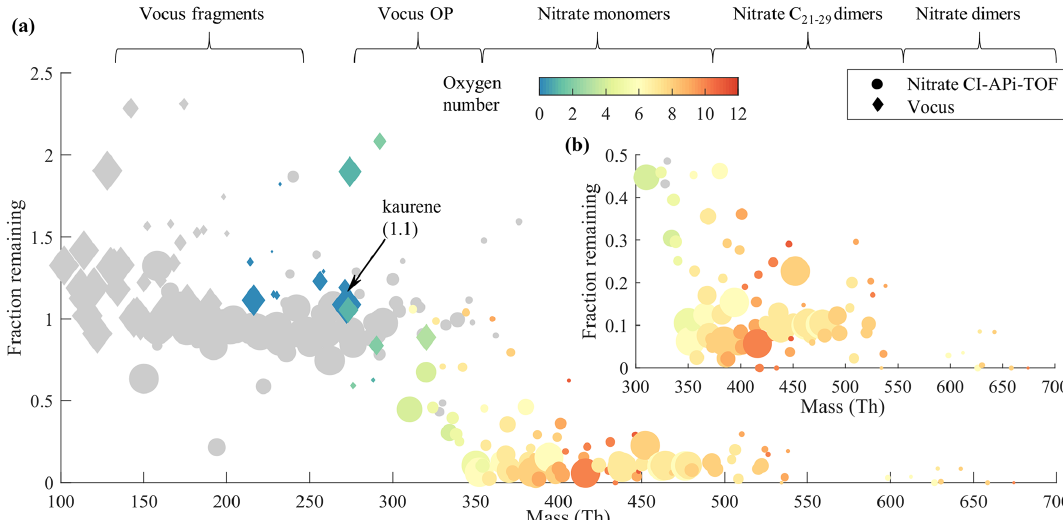
Figure 6. Seed injection behavior; the “fraction remaining” corresponds to the ratio of the signal with seed particles to the signal without seed. We emphasize that the molar mass indicated on the x axis is without the reagent ions, unlike many previous studies (Peräkylä et al., 2020; Räty et al., 2021). Species with less than 15 carbon numbers in the composition are colored with gray, while the color scale indicates the oxygen content for species with 15 or more carbon atoms. The areas of the circles (nitrate CI-APi-TOF) and diamonds (Vocus) are scaled linearly to the magnitude of each compound’s signal when there were no seed particles in the chamber (different scaling for the two instruments). Compounds with the average signal intensities lower than 3 times the standard deviation are excluded from the plot. The text at the top shows roughly which compound groups are found in which parts of the mass range. The “Vocus fragments” refers to the kaurene fragments, and “Vocus OP” refers to C 18 − 20 oxidation products. “Nitrate monomers”, “Nitrate C 21 − 29 dimers”, and “Nitrate dimers” represent the C 18 − 20 HOM monomers, C 21 − 29 HOM dimers, and C 37 − 40 HOM dimers measured with nitrate CI-APi-TOF, respectively. A zoomed-in view of the mass range above 300Th is shown in (b)